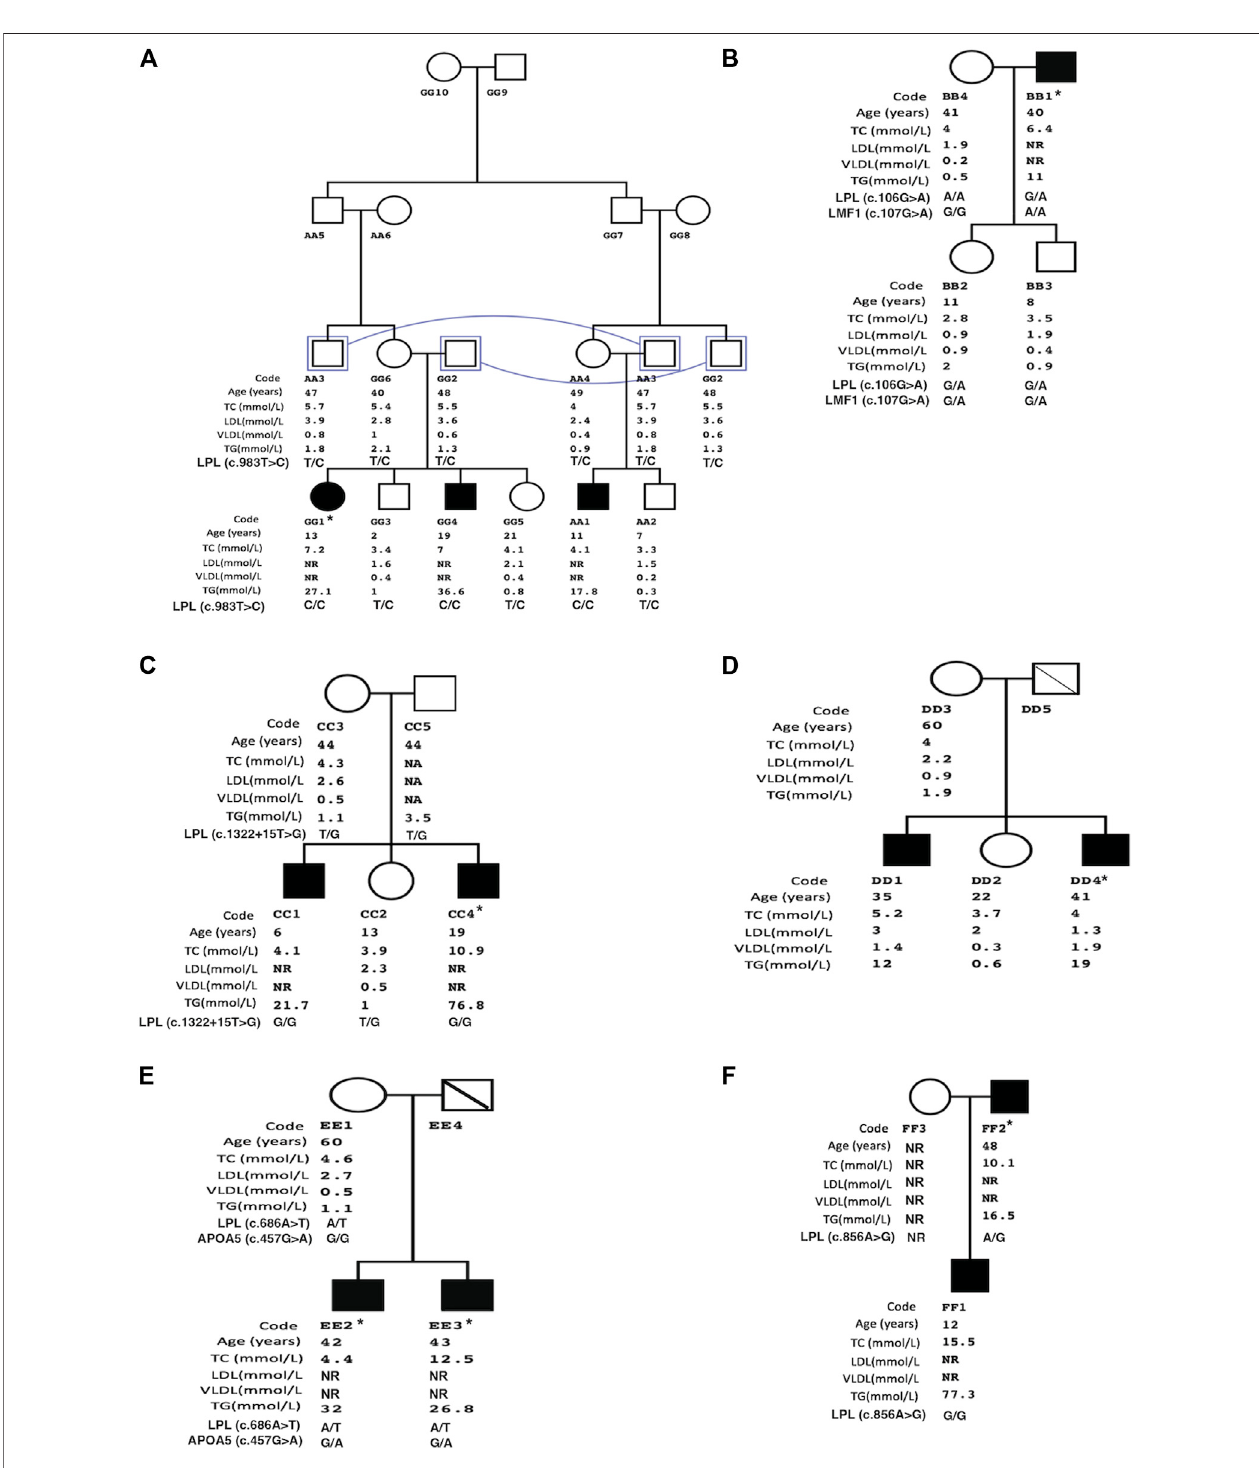
FIGURE1| Familypedigreestructuresofpatientswithfamilialhypertriglyceridemia.Illustratesfamilytreesofstudygroups(A=Family1toF=Family6).Studygroup data includes age, total cholesterol (TC), low-density lipoprotein (LDL), very-low-density lipoprotein (VLDL), and triglycerides (TG). Squares and circles represent male and female family members, respectively, and fi lled symbols represent affected subjects with familial hypertriglyceridemia. * Index case, NR: not recorded, connecting line: same individual, diagonal line: deceased subject.